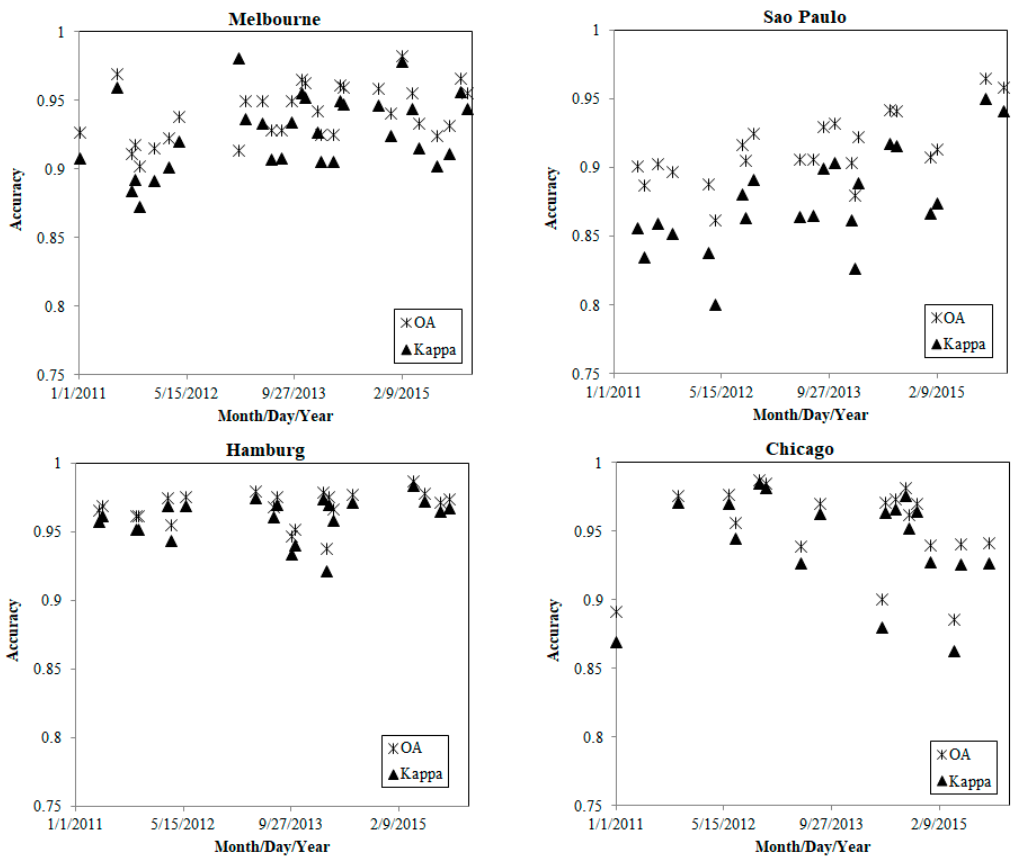
Figure 5. Overall accuracy and kappa coefficient of the urban land cover classification results in the four selected cities; the time scale and accuracy scale are consistent in four cities.